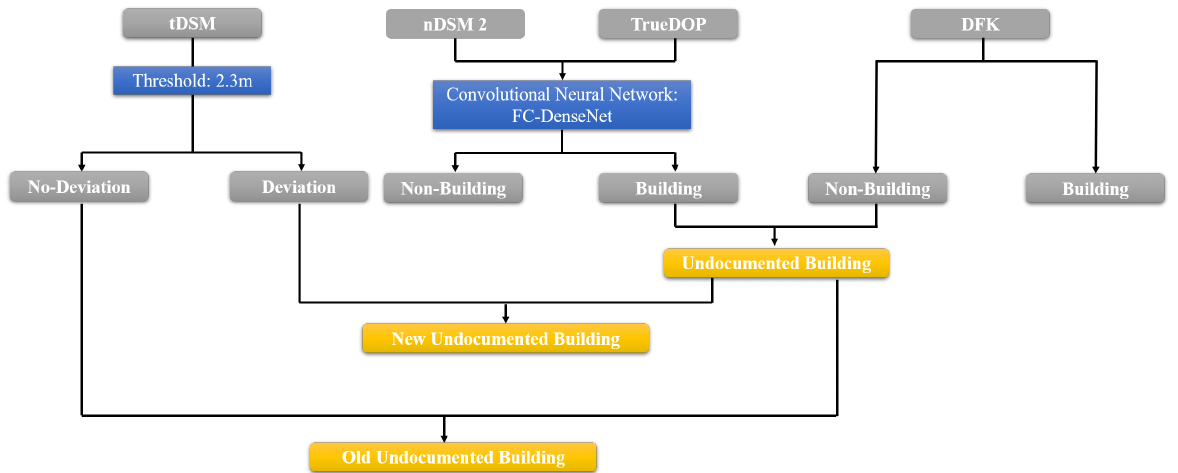
Figure 3. Flowchart of the proposed approach for the detection of undocumented